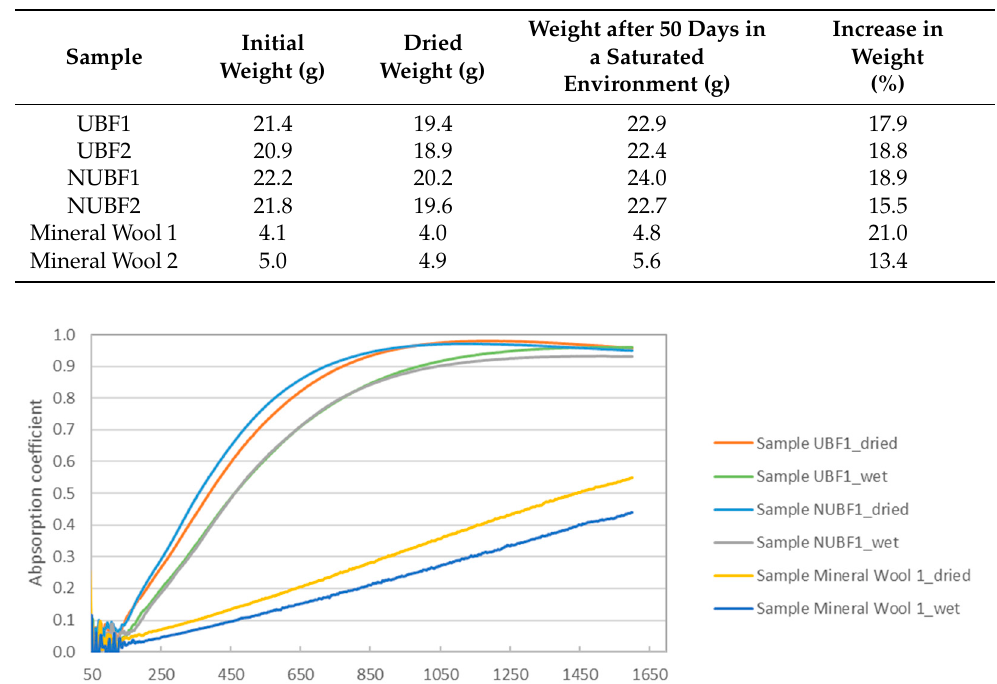
Table 1. Variation in weight of samples after initial drying and after remaining in a saturated environment for 50 days.